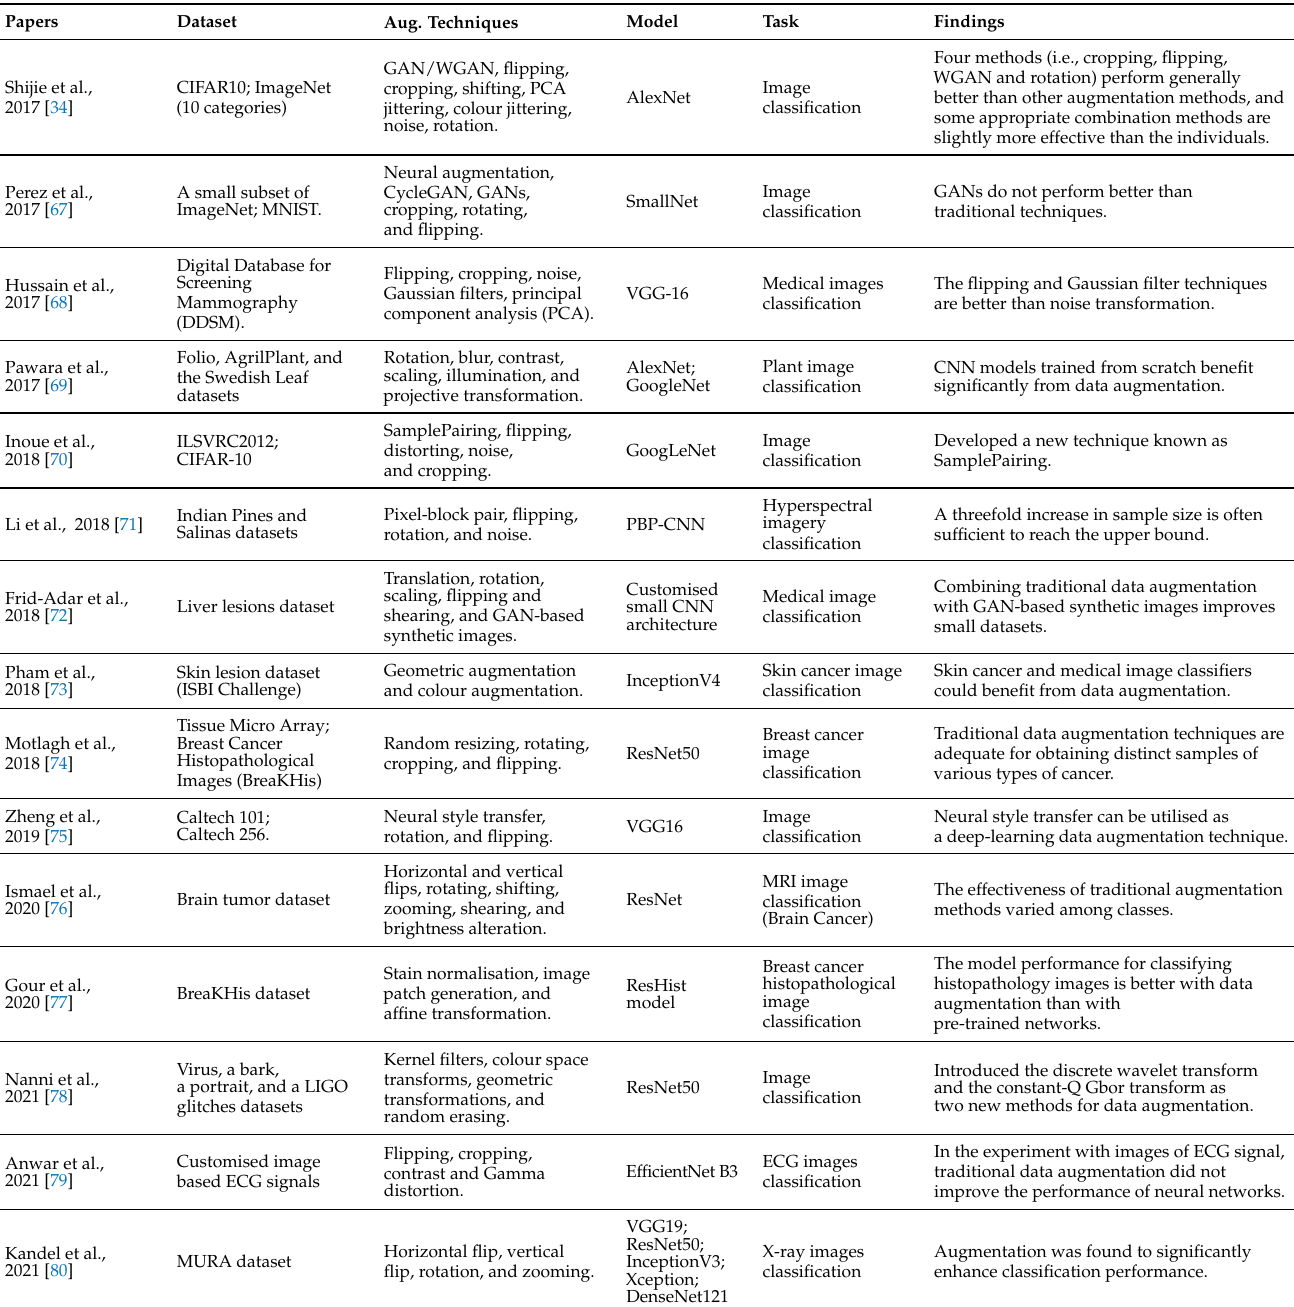
Table 1. Survey of data augmentation techniques in recent image classification